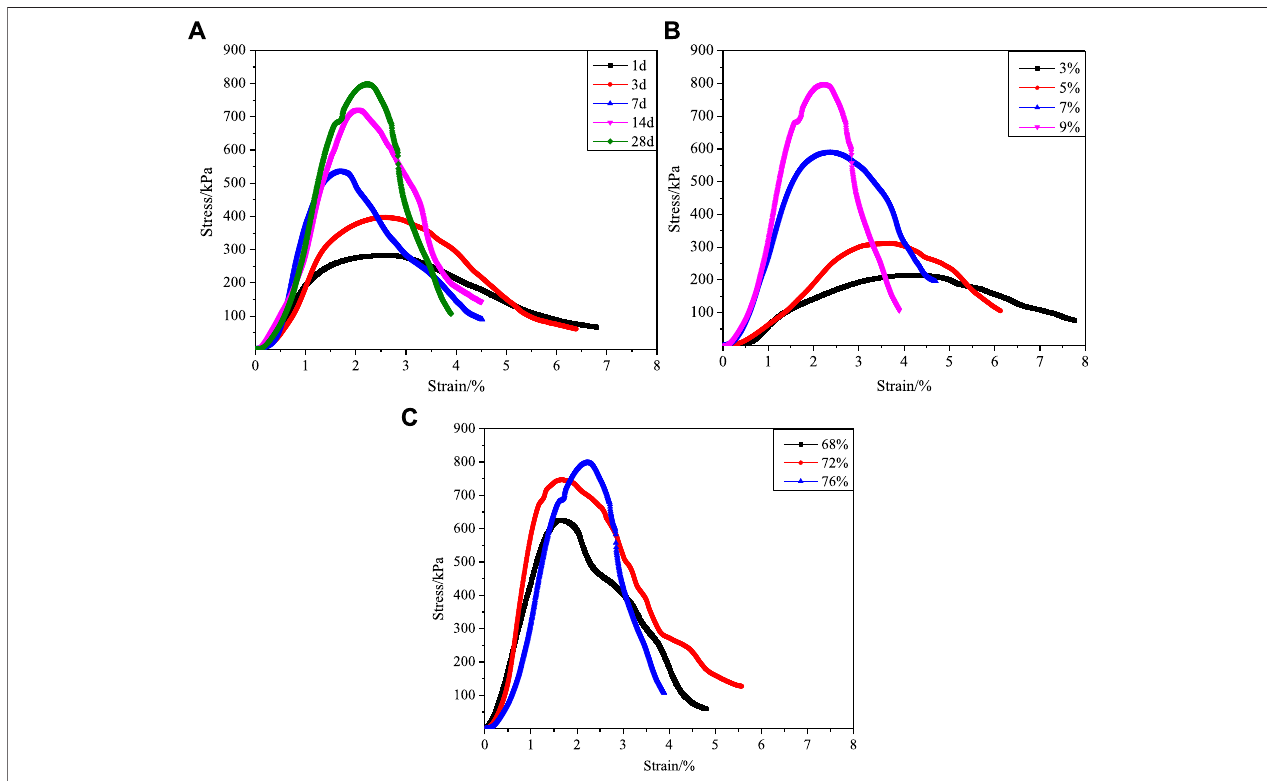
FIGURE 8 | The stress – strain curve of multi-factor. (A) Curves of different curing time. (B) Curves of different binder content. (C) Curves of different soild content.